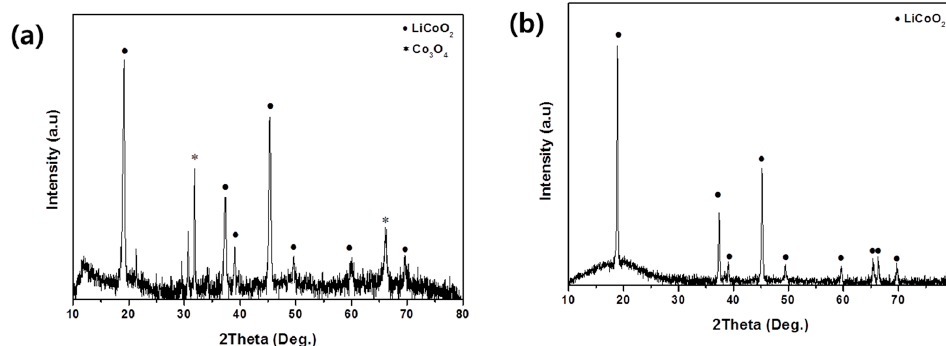
Figure 6. XRD spectrum of LiCoO 2 produced from Co-oxalate by reaction with ( a ) Li 2 CO 3 and ( b ) LiOH.